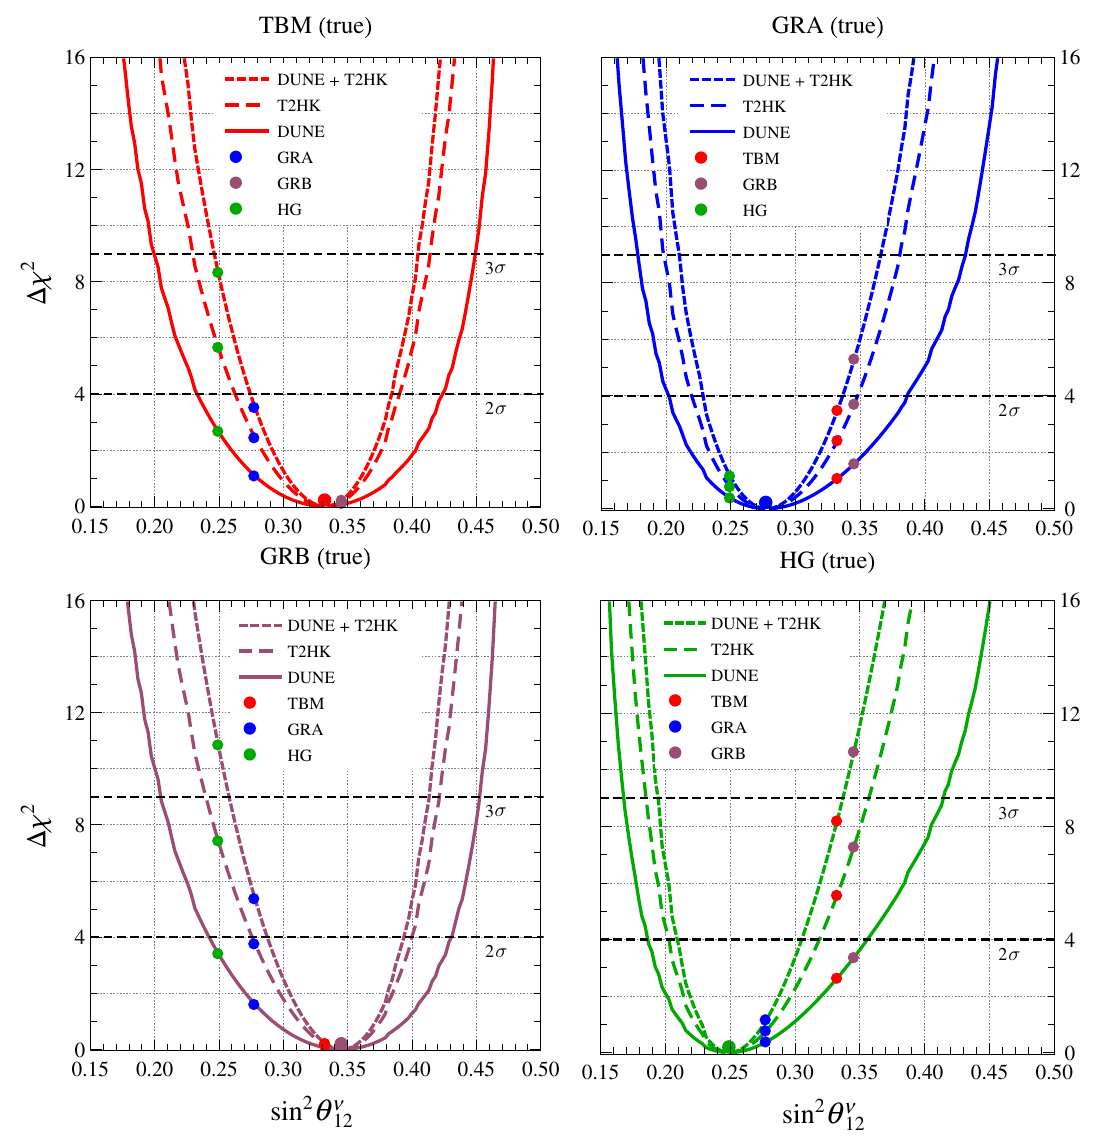
Fig. 3 Sensitivities of DUNE, T2HK, and their combination to distin- guish between the TBM, GRA, GRB, and HG symmetry forms under the assumption that one of them is realised in Nature. In the top left (right) panel the assumed true symmetry form is TBM (GRA), while